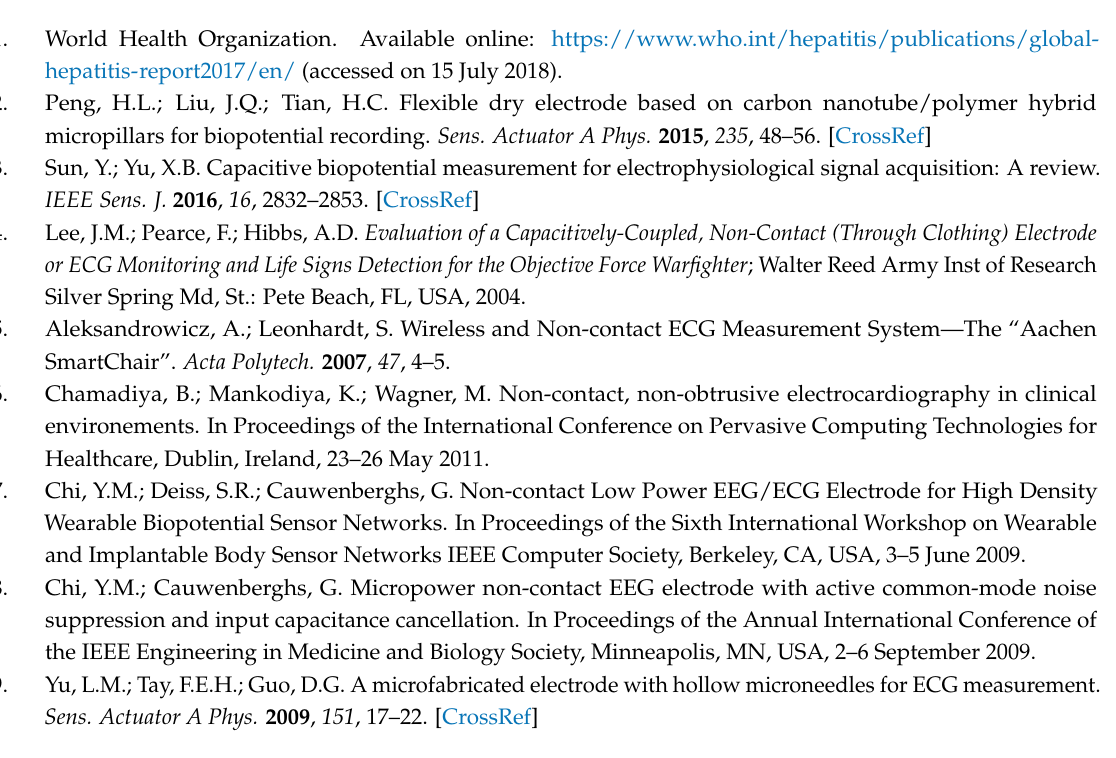
Figure S1: ECG signals of a male volunteer (age: 38) under resting and walking state for various MWCNT concentrations, Figure S2: ECG signals of a female volunteer (age: 31) under resting and walking state for various MWCNT concentrations, Figure S3: ECG signals of a male volunteer (age: 24) under resting and walking state for various MWCNT concentrations, Figure S4: ECG signals of a male volunteer (age: 23) under resting and walking state for various MWCNT concentrations, Figure S5: ECG signals of a male volunteer (age: 18) under resting and walking state for various MWCNT